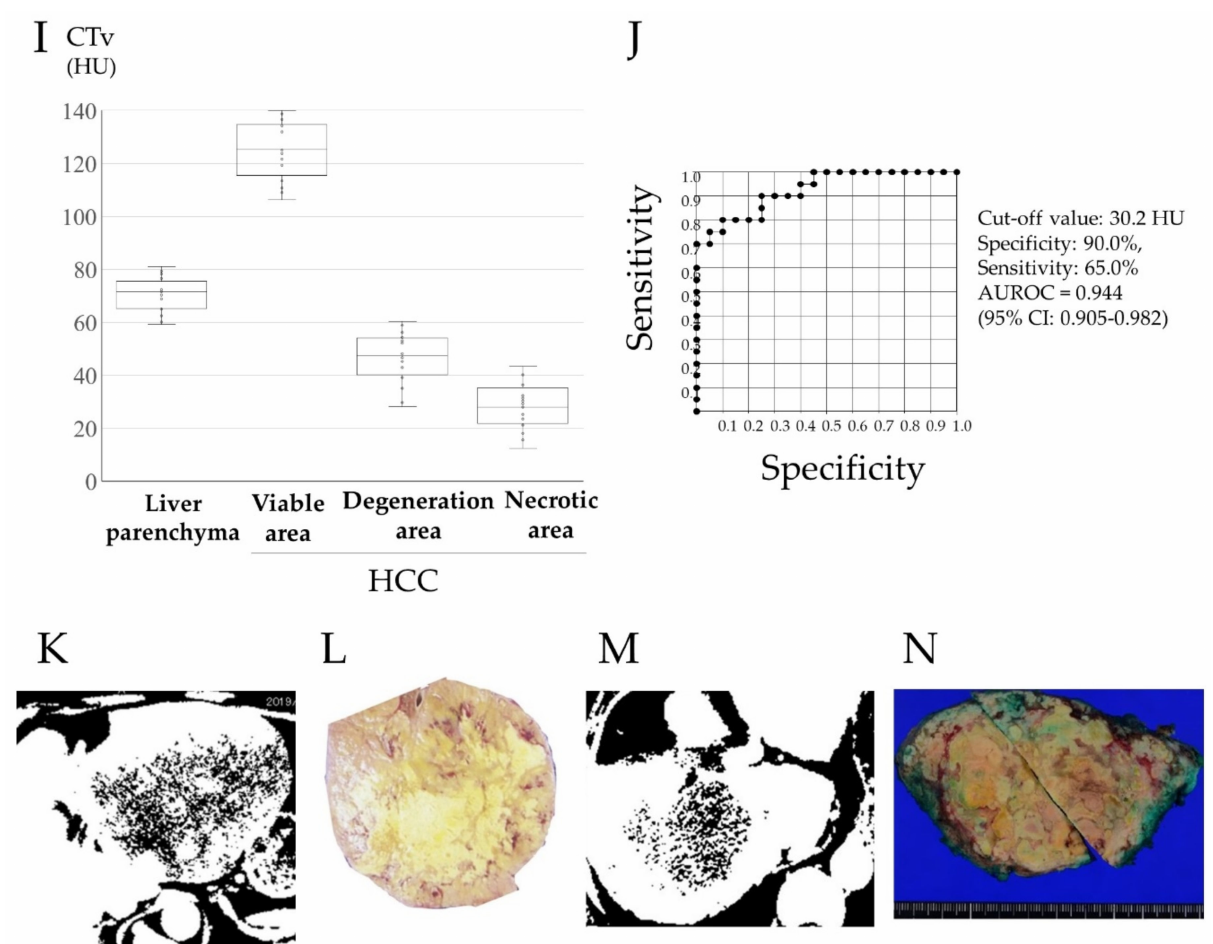
Figure 2. Preoperative contrast-enhanced computed tomography images and pathological findings in the resected specimen. Images of the arterial phase of computed tomography (CT) in HCC patients before ( A , C ) and after ( B , D ) lenvatinib administration, and pathological findings in hepatectomy specimens from HCC patients after lenvatinib therapy in these patients ( E – H ). 2E shows the post- operative histopathological findings corresponding to the asterisk (*) in the CT image in Figure 2B. The arrowheads in Figure 2B,D correspond to the arrowheads in Figure 2F,H, and the circles in Figure 2B,D correspond to Figure 2G, and the circle in Figure 2H. The arrow in Figure F indicates the artery in the degenerated tumor. CT values (CTav) corresponding to the four histological regions (liver parenchyma (LP), viable area of tumor (VA), degenerated area of tumor (DA), and necrotic area of tumor (NA)) ( I ). HU, Hounsfield unit. Receiver-operating characteristic (ROC) curve analysis of CTav for differentiating necrotic areas from degenerated tumor areas ( J ). AUC, area under the ROC curve. Two binary images based on preoperative N30-CTav in HCC patients ( K , M ) and the postoperative macroscopic findings corresponding to the two binary images ( L , N ). N30-CTav: a CTav of 30 HU was set as the threshold value for histological